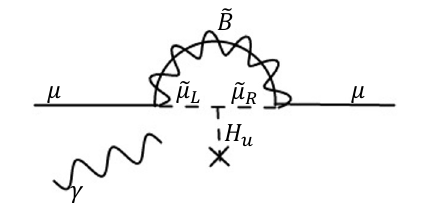
Figure 2 . A SUSY Feynman diagram contributing to the muon g − 2 , enhanced for large µ and tan β . The photon line may be attached to either of the